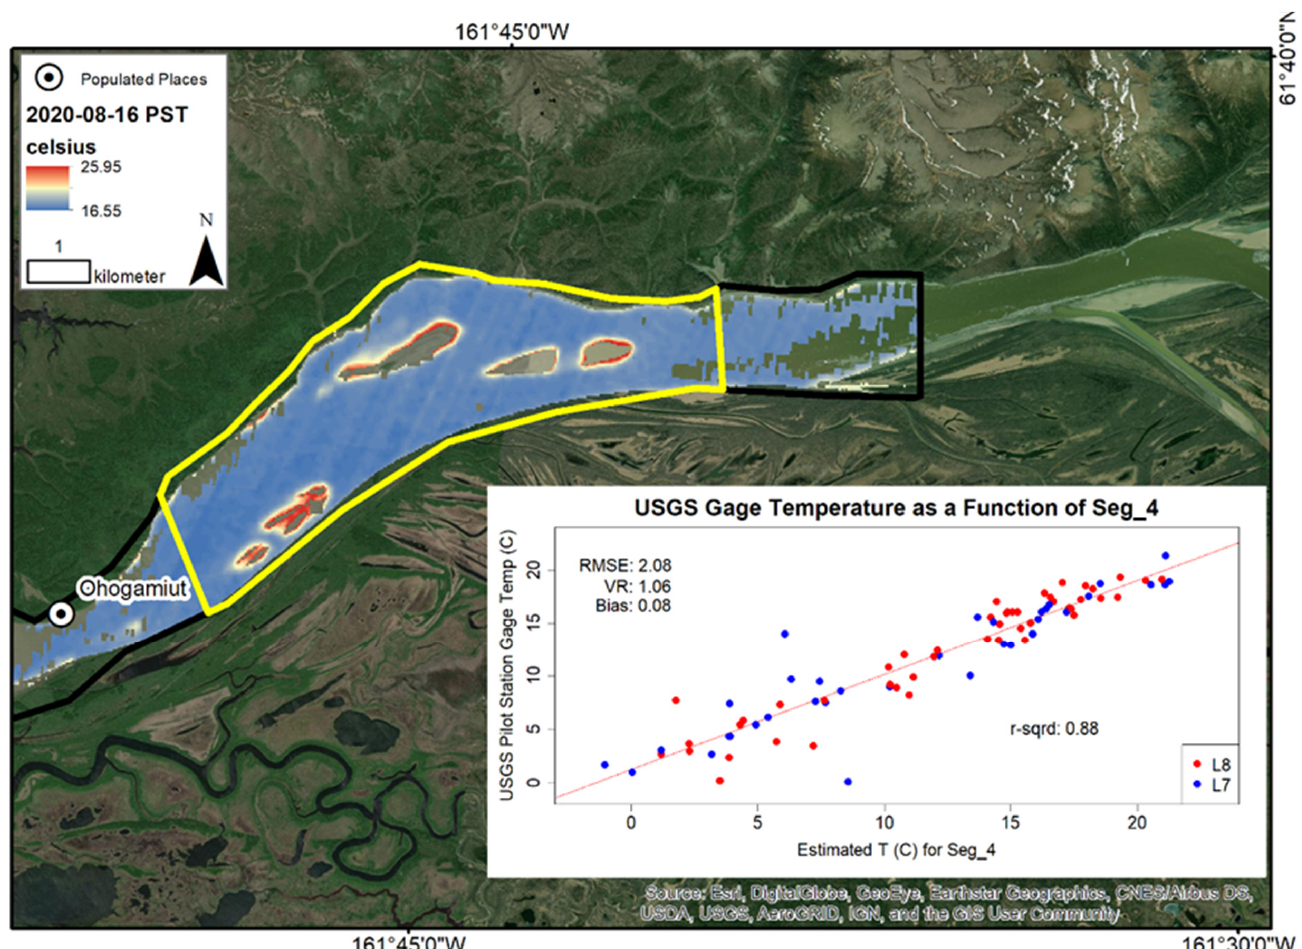
Figure A2 . Within segment 4, the river is a single channel with several mid-channel islands that become submerged during high river stages and are barren sand bars at low river stage as indicated by a lack of permanent woody vegetation. In the scene above, water levels on 16 August 2020 were low enough to expose the islands. They present as lenticular data gaps with warm-water margins. Note the visual difference between these data gaps and the permanent NoData gaps within Segment 3. Agreement between estimated water temperature and streamgage data is good (RMSE = 2.08 °C, r 2 = 0.88). The north shore of the river is rolling uplands of the Ilivit Mountains with steep bluffs along the river, including Serpentine Bluff. The southern shore of the river is vegetated flood plain with numerous crescentic abandoned channels.